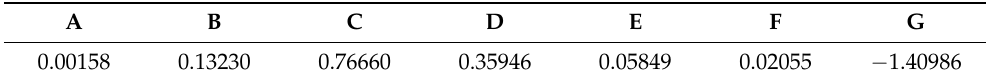
Table 2. Solution parameters results of first model for batteries 1, 2, and